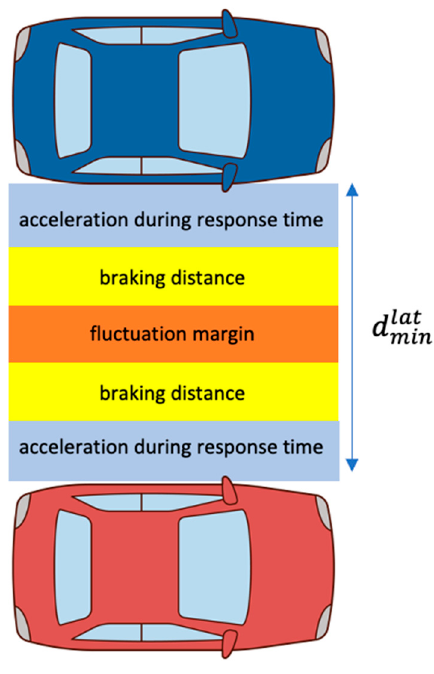
Figure 4. Lateral safe distance.